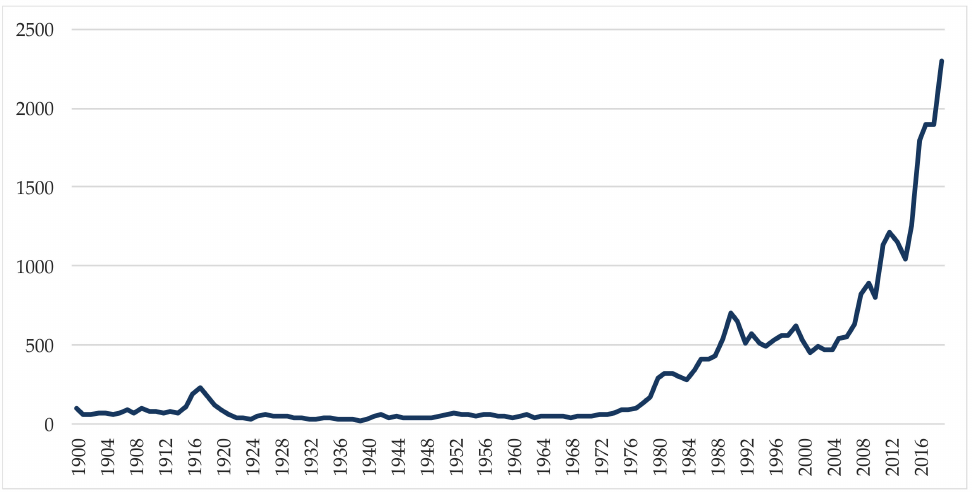
Figure A8. Copper price dynamics in USD/t (build on the data from [25]), the red line is a trend.